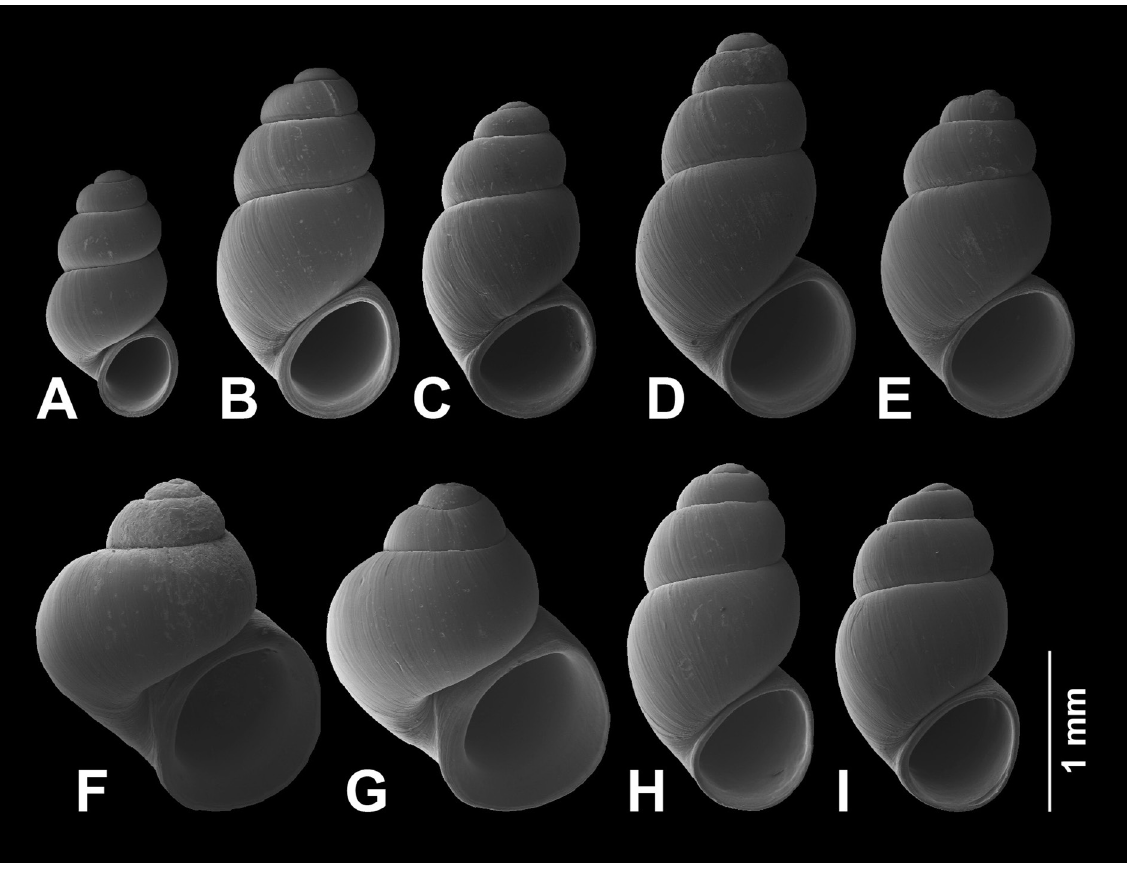
Fig. 5. Shells. SEM photographs of paratypes. A . Catapyrgus jami sp. nov. B – C . Opacuincola lisannea sp. nov. (B, topotype; C, northern locality). D – E . Op. gretathunbergae sp. nov. F – G . Op. mete kahurangi subsp. nov. H – I . Obtusopyrgus farri sp.